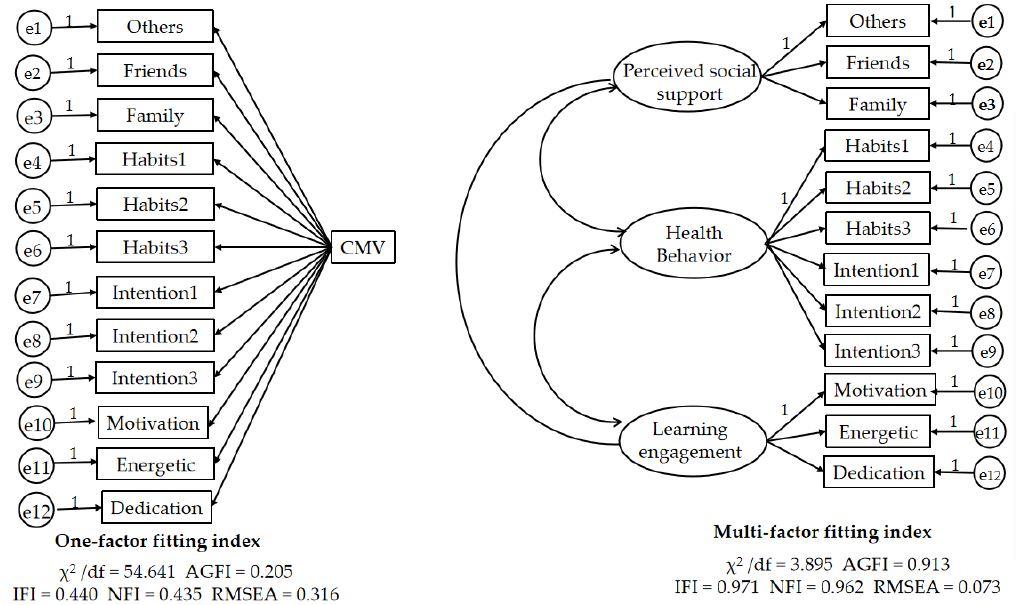
Figure 2. Common method deviation test. Note: e1-e12 are residual terms.